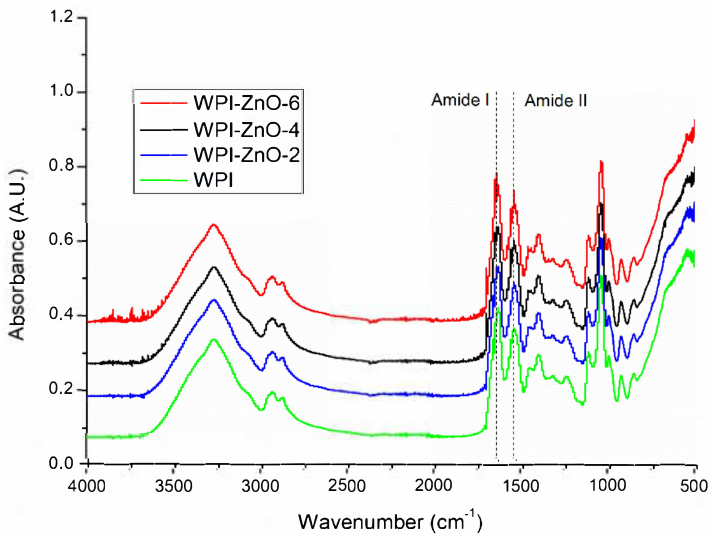
Figure 6. XRD spectra of n-ZnO (black), WPI (green) and WPI–ZnO-6 composite film (red).